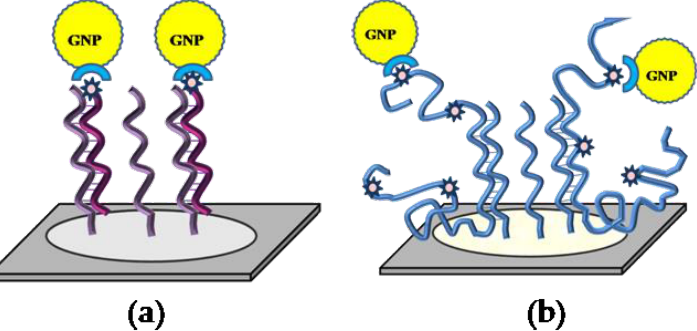
Figure 2. Schematic representation of hybridization of biotin-labeled short target oligonucleotides ( a ) and long target DNA ( b ) on silicon DNA microchips. —capture oligonucleotide probes immobilized on the microchip surface, —a conjugate of streptavidin with gold nanoparticles, —target oligonucleotides labeled with biotin, —target DNA labeled with biotin.